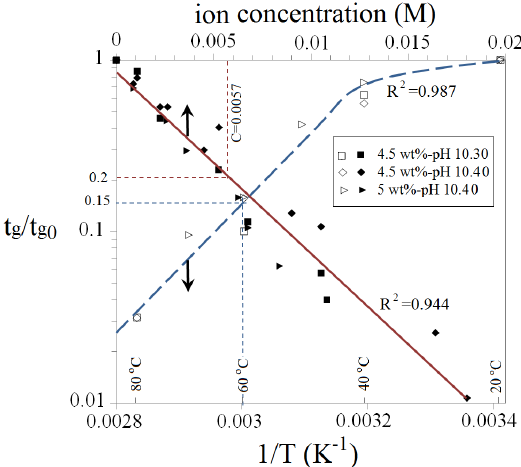
Figure 12. Normalized gelation time ( t temperature and salt concentration for 4.5 wt% and 5 wt% Na-silicate solutions with different pH